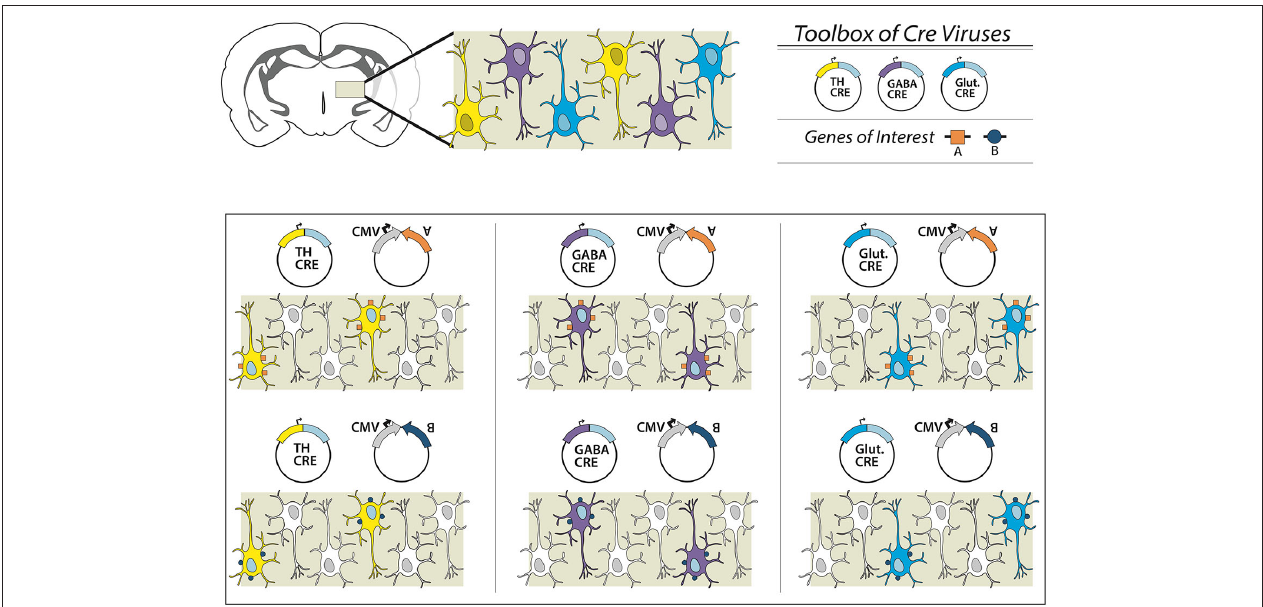
viruses. Depending on the Cre virus chosen, a different neuronal population is targeted. In other experiments, the effector itself can be switched (e.g., gene B), and thus multiple genetic manipulations can be conducted within one specific targeted neuronal subpopulation. In this way, the researcher is only required to create the appropriate DIO-effector construct once, instead of attempting multiple promoter-effector combinations, which may be of limited value given variegations in promoter-gene interaction and weak promoter